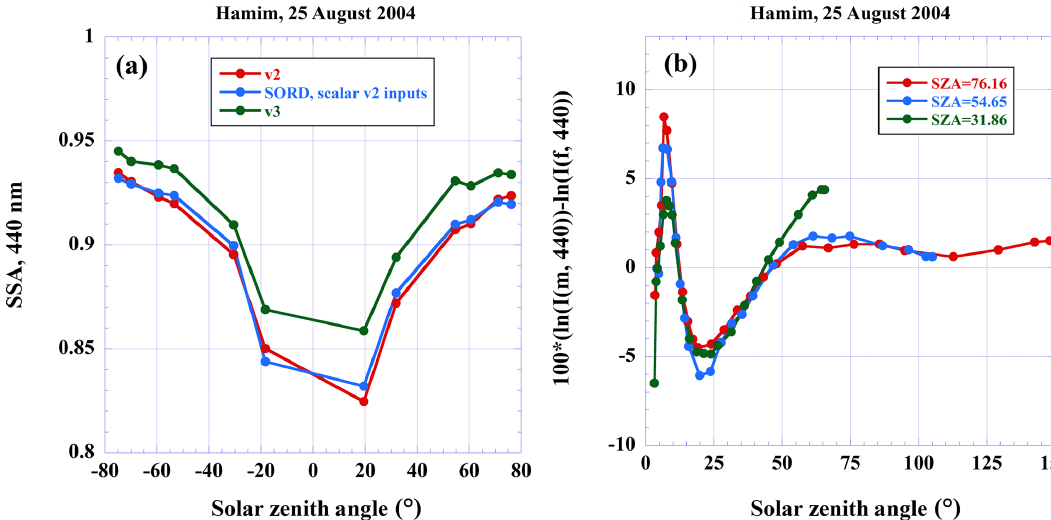
Figure 7. Data from Hamim (UAE) on 25 August 2004 showing (a) diurnal variability of SSA at 440nm retrieved from almucantars by the V2 and V3 algorithms and algorithm of V3 in scalar mode using inputs of V2; (b) the relative percent difference between measured and fitted NSRs at 440nm for three different SZAs.